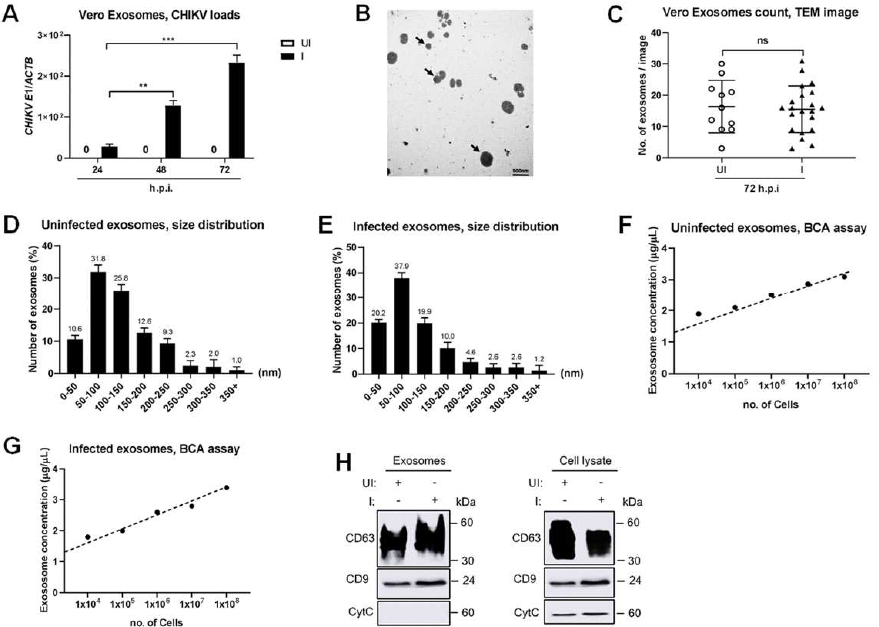
Figure 2. Physical characterizations and quantification of Vero−derived EVs with CHIKV infection. ( A ) Analysis of CHIKV loads in isolated exosomes derived from CHIKV−infected Vero cells at 5 MOI by qRT−PCR assay. ( B ) TEM images represented the exosome morphology that was isolated from CHIKV−uninfected (UI) or 5 MOI CHIKV−infected (I) Vero cells at 72 h.p.i.; Black arrow indicated isolated exosomes; Scale bar, 500 nm (magnification, 30,000×). ( C ) Counting of small EV numbers that were isolated from uninfected and 5 MOI CHIKV-infected groups at 72 h.p.i. The number of small EVs was represented on Y−axis. TEM images were gathered from at least three independent exosome isolation manners. The n indicates the total image number used in this analysis. ( D , E ) The distribution of the heterogeneous EVs size isolated from CHIKV−uninfected ( D ) or CHIKV−infected ( E ) Vero cells was demonstrated by the DLS technique. The number in the percentage and size range of each EV subgroup was indicated on Y−axis and X−axis, respectively. Based on the total number of small EVs in each size range, the percentages were calculated. ( F , G ) Total protein levels of Vero−derived small EVs from CHIKV−uninfected ( F ) or 5 MOI CHIKV−infected groups at 72 h.p.i. ( G ) were quantified by the BCA method. The total protein concentration of each small EV (Y−axis; measured as μg/μL) was plotted against the increase in Vero’s cell number (X−axis). In both groups, higher increments in total protein concentrations of small EVs progressively increased with the number of Vero cells. ( H ) CD63 and CD9, which are tetraspanin proteins and well recognized as exosome biogenesis markers, were detected on the exosomes isolated from the CHIKV−uninfected or 5 MOI CHIKV−infected Vero cells with the absence of the cytochrome−C (CytC), the negative exosome marker, in isolated exosomes by immunoblotting technique; ns, not significant; **, p < 0.01; ***, p < 0.0001.